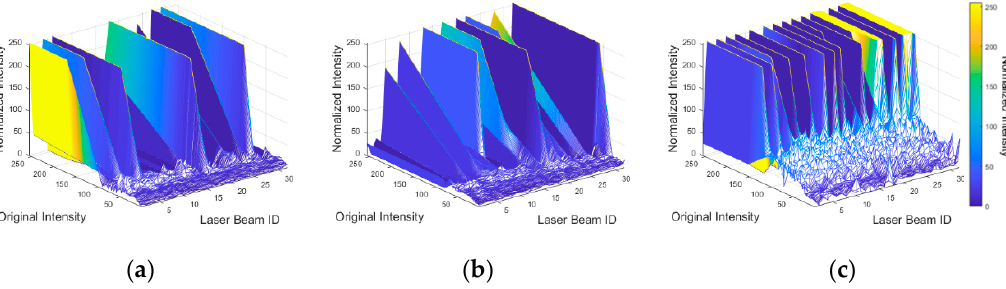
Figure 18. Intensity normalization maps associated with an HDL 32E LiDAR unit for ( a ) ROI 1, ( b ) ROI 2, and ( c ) ROI 3.